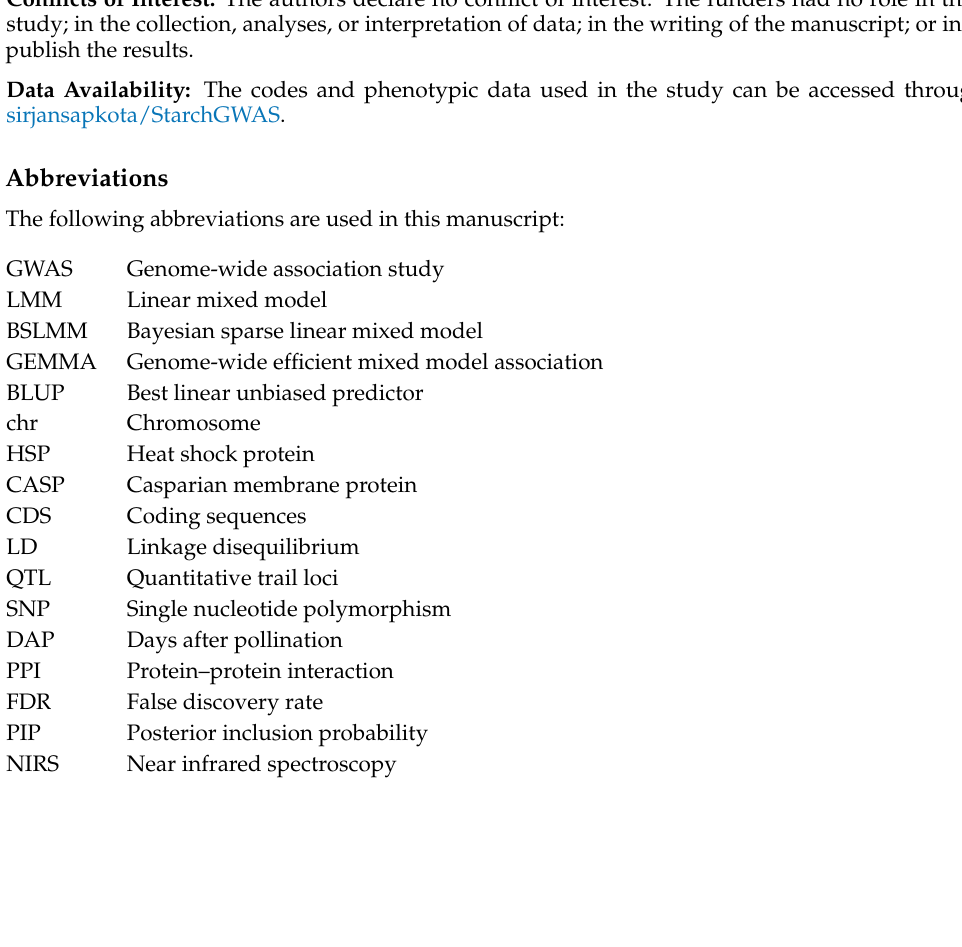
nucleotide polymorphism. Table S3. KEGG Pathway and UniProt keywords enrichment results for gene network of HSP90-6 gene, Sobic.008G111600 . FDR: false discovery rate, Observed and Expected refer to the gene count for the network. Table S4. Summary of significant epistatic interaction between associated variants and variants within genes that show high protein–protein interaction with heat shock protein 90-6 ( Sobic.008G111600 ). Chr: chromosome, β int : regression coefficient of interaction. Table S5. Null distribution of mean posterior inclusion probability (PIP) values from ten simulated data sets across quantiles to determine the empirical significance cutoff for associations from the Bayesian sparse linear mixed model